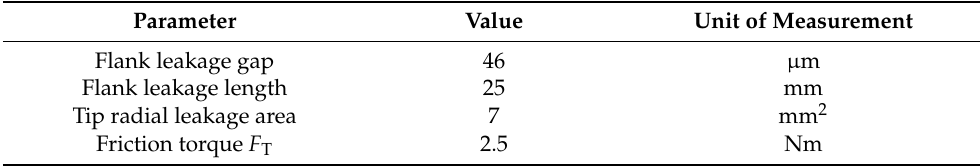
Table 3. Model calibration